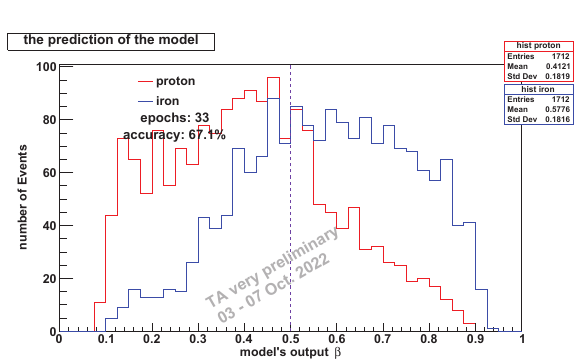
Figure 7: The response distribution of the test data to the ma- chine learning model. The purple dashed line is drawn at β = 0 .